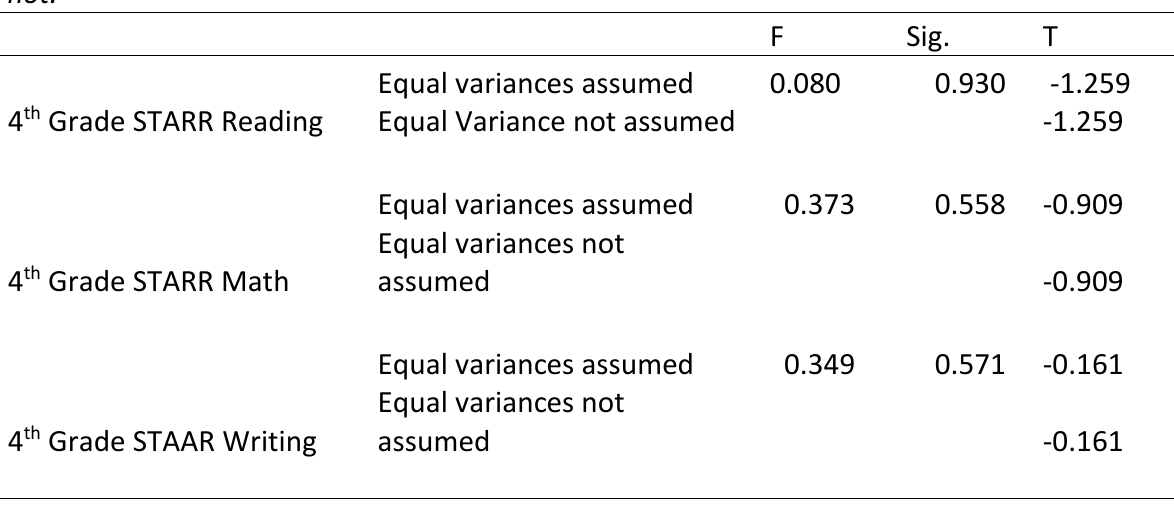
Table 7 : Statistics for Levene’s Test for Equality of Variances: 4 th Grade Student Performance on STAAR Reading, Math, Writing, in campuses implementing ACE and those campuses which do not.